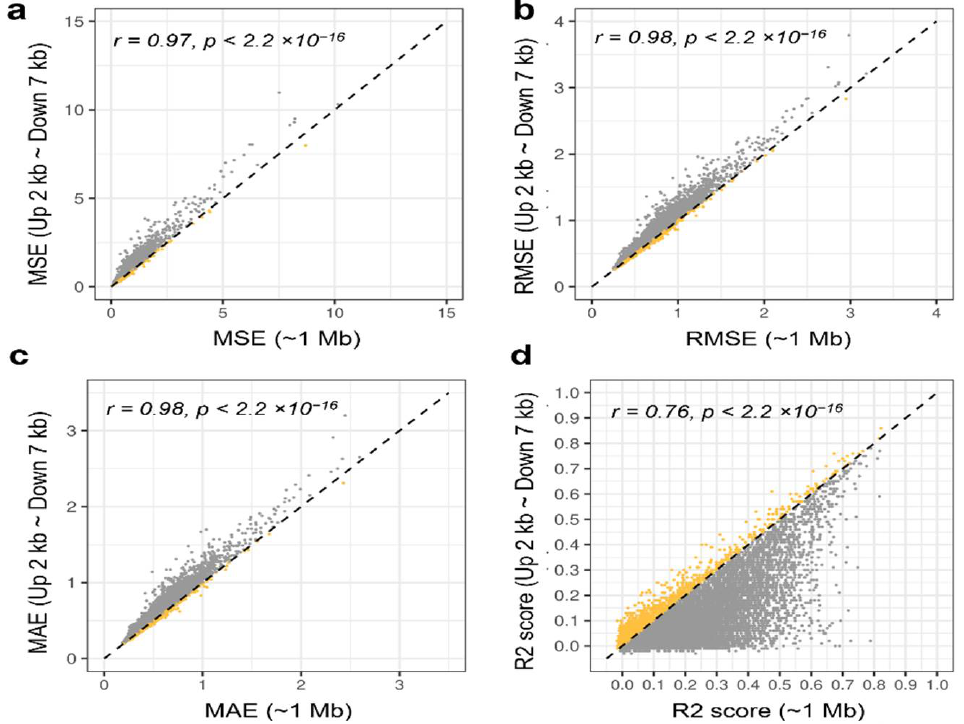
Figure 4. Performance comparison of ElasticNet depending on probe distance. Gene expression prediction was performed with ElasticNet using probes within ± 1 Mb of TSS and ElasticNet using probes located in the region of 2 kb upstream to 7 kb downstream. Each model’s performance was measured and compared in terms of ( a ) MSE, ( b ) RMSE, ( c ) MAE, and ( d ) R2 score. Genes with better performance using probes within 2 kb upstream to 7 kb downstream are highlighted in yellow. The letter r denotes Pearson’s correlation coefficient, and p is the p value for Pearson’s correla- tion.